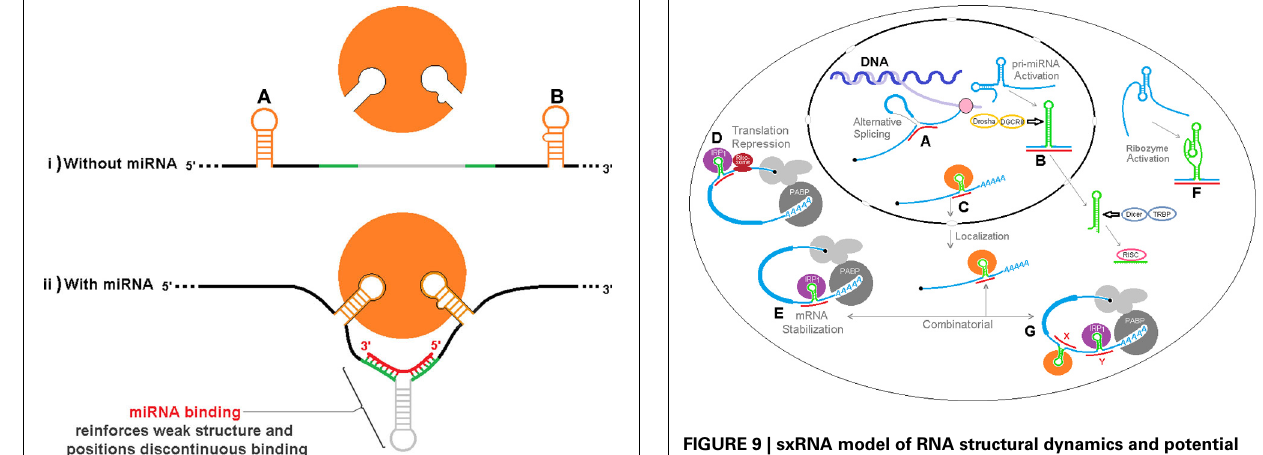
FIGURE 9 | sxRNA model of RNA structural dynamics and potential post-transcriptional regulation. sxRNA There are a multitude of downstream results that may be modulated by a ncRNA to mRNA 3-way junction. A number of hypothetical effects are depicted where ncRNAs could: (A) interact with nascent pre-mRNA to affect alternative splicing, perhaps by affecting splicing factor recognition sites or (as depicted here) by binding to exon regions on both sides of a particular splice junction, (B) affect the structural conformation of an miRNA primary transcript, determining its availability for trimming to pre-miRNA and nuclear export, (C) reinforce a stem loop binding motif for a localization RBP, determining mRNA shuttling destination, (D) further lessen translation via iron regulatory protein by stabilizing a 5 (cid:2) IRE in particular mRNAs, (E) alternatively, enhance mRNA stabilization via iron regulatory protein by stabilizing a 3 (cid:2) IRE in particular mRNAs (F) activate structure dependent ribozymes, (G) act in a combinatorial fashion with multiple signals in a single